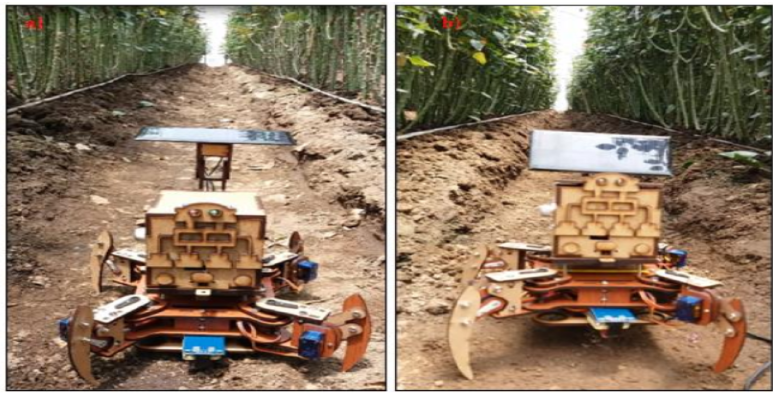
Figure 10. Autonomous system with